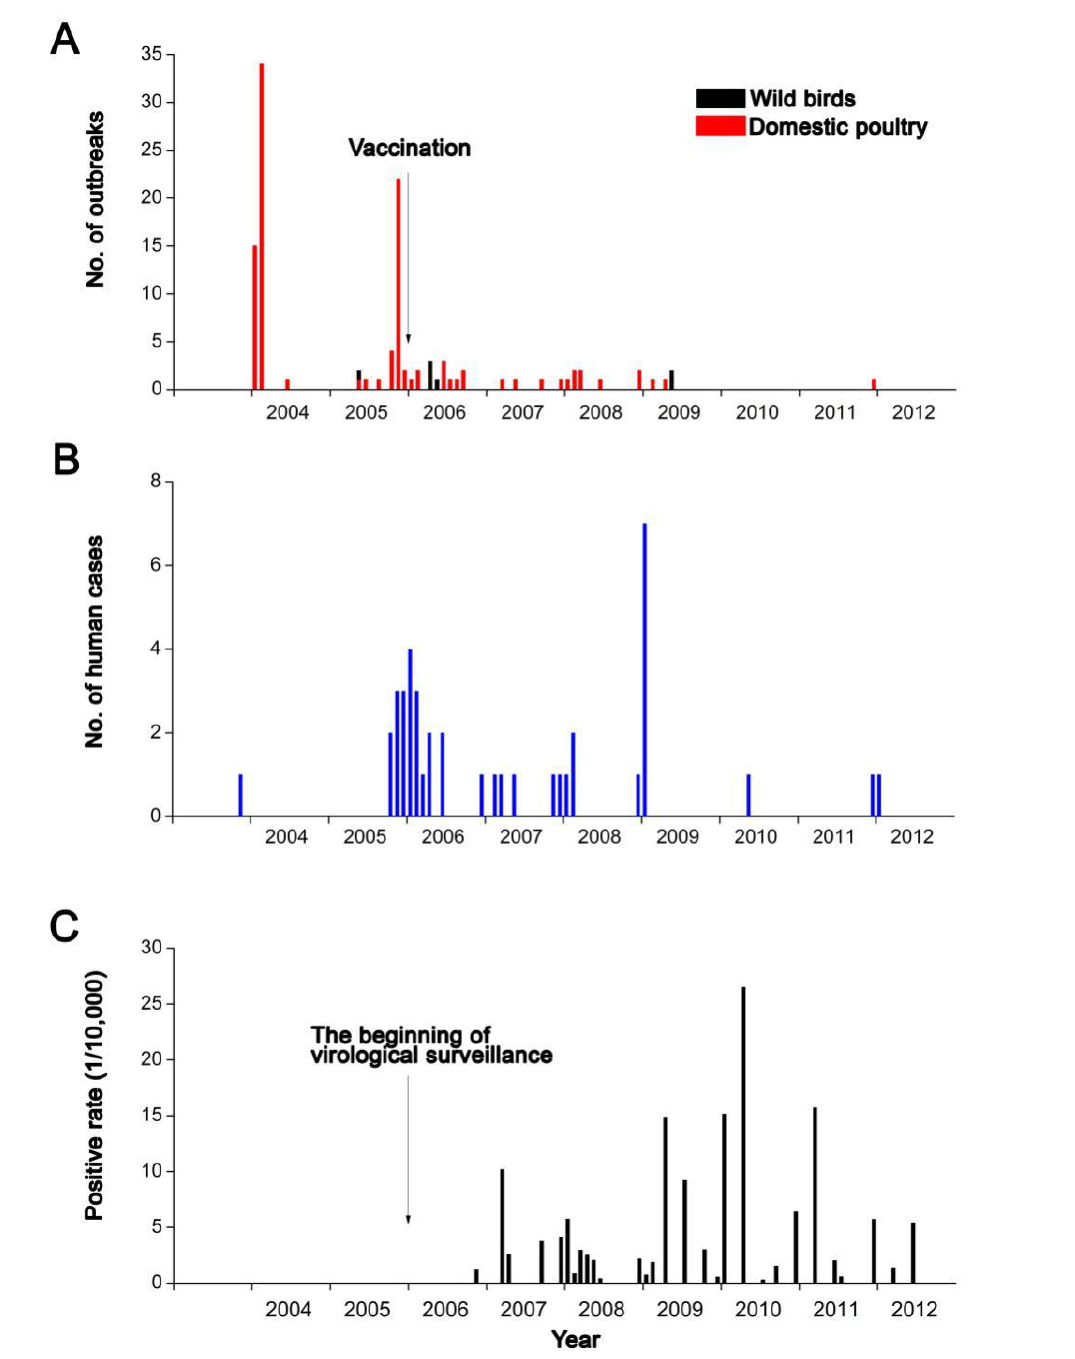
Figure 1. Temporal distribution of HPAI H5N1 in mainland China. ( A ) Outbreaks in domestic poultry and wild birds. The red and black bar charts indicate the number of outbreaks in domestic poultry and in wild birds, respectively. The black arrow indicates the beginning of vaccination campaign in domestic poultry in mainland China; ( B ) Number of human cases with HAPI H5N1 infection; ( C ) Positive rate in virological surveillance. The black bar charts indicate the positive rate in virological surveillance, and the black arrow indicates the beginning of the routine virological surveillance in mainland